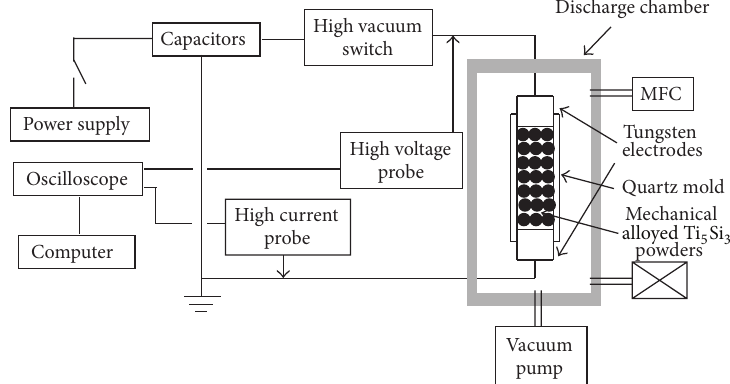
Figure 1: A schematic diagram of the experimental setup for the electrical discharge consolidation (EDC)